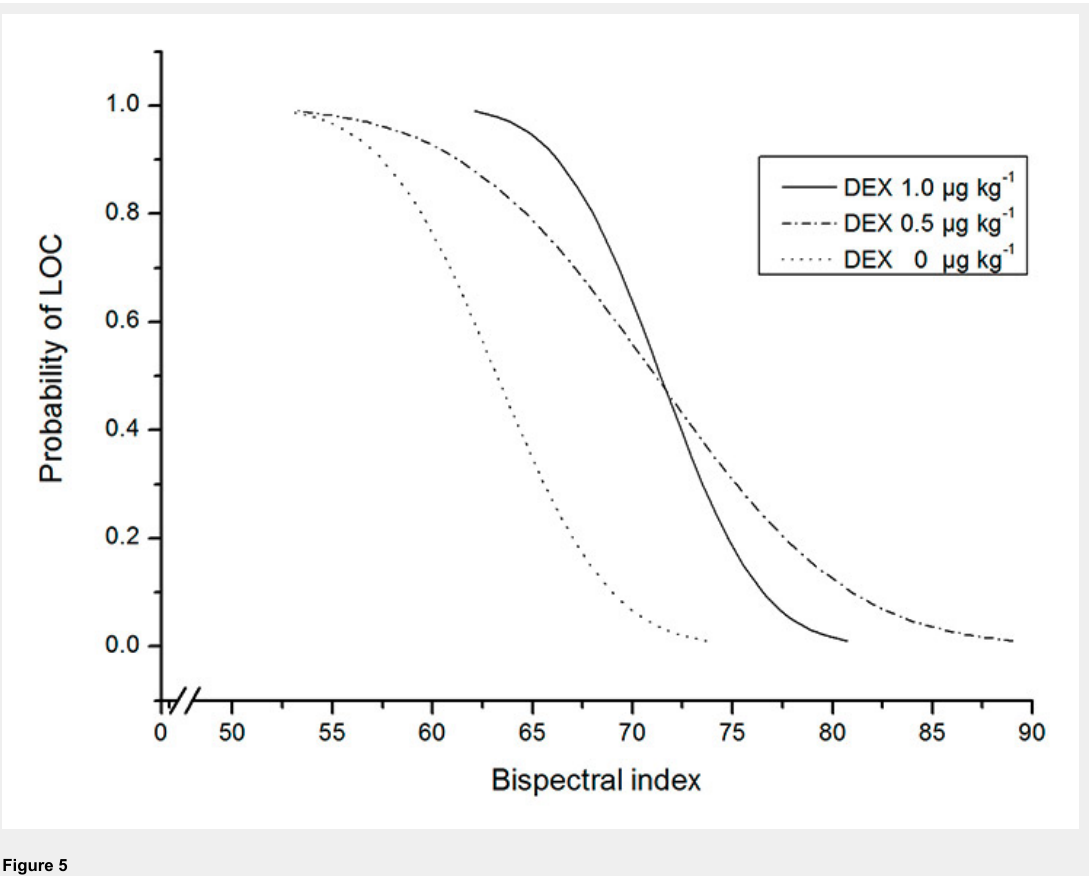
Figure 5 The relationship between the probability of loss of consciousness (LOC) and the bispectral index. (DEX =